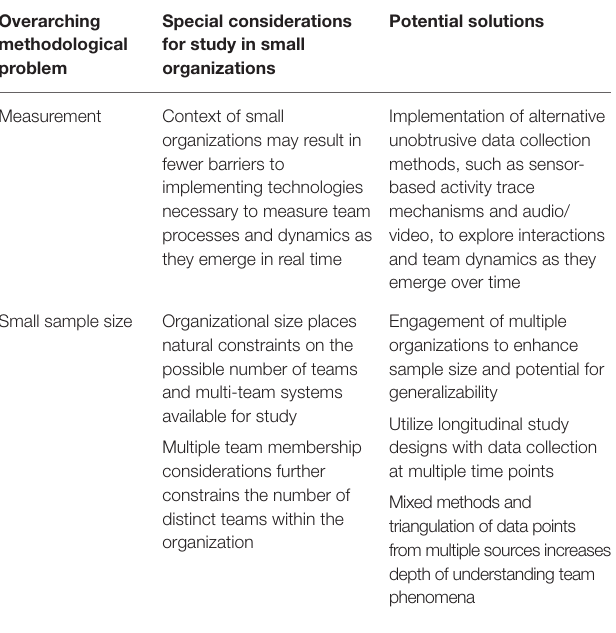
TABLE 4 | General methodological considerations for studying teams in small organizations. Overarching methodological